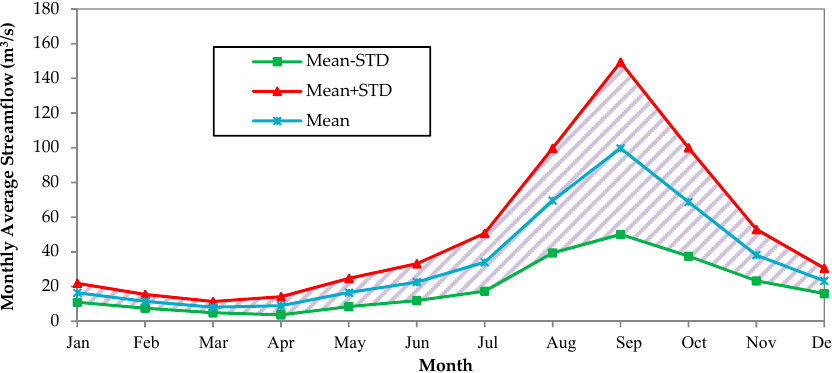
Figure 1. The average and standard deviation of monthly streamflow at gauge station P14.